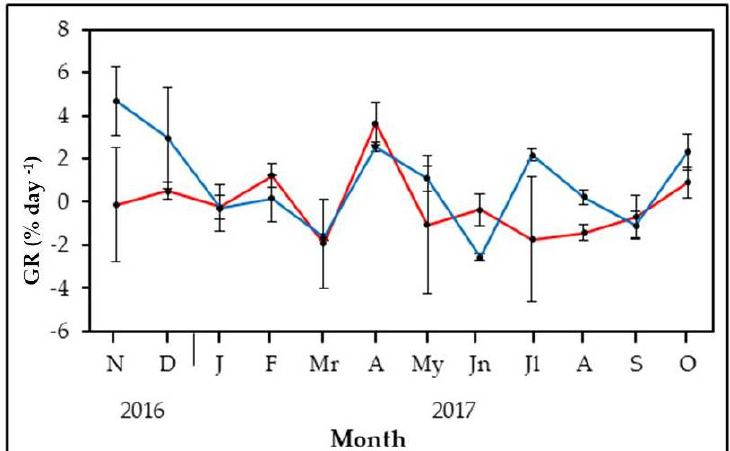
Figure 2. Weekly net growth rate of Gracilaria gracilis (red line) and Chondracanthus teedei (blue line) from November 2016 to October 2017 in salina La Esperanza (Cadiz, Spain). Error bars denote SE.